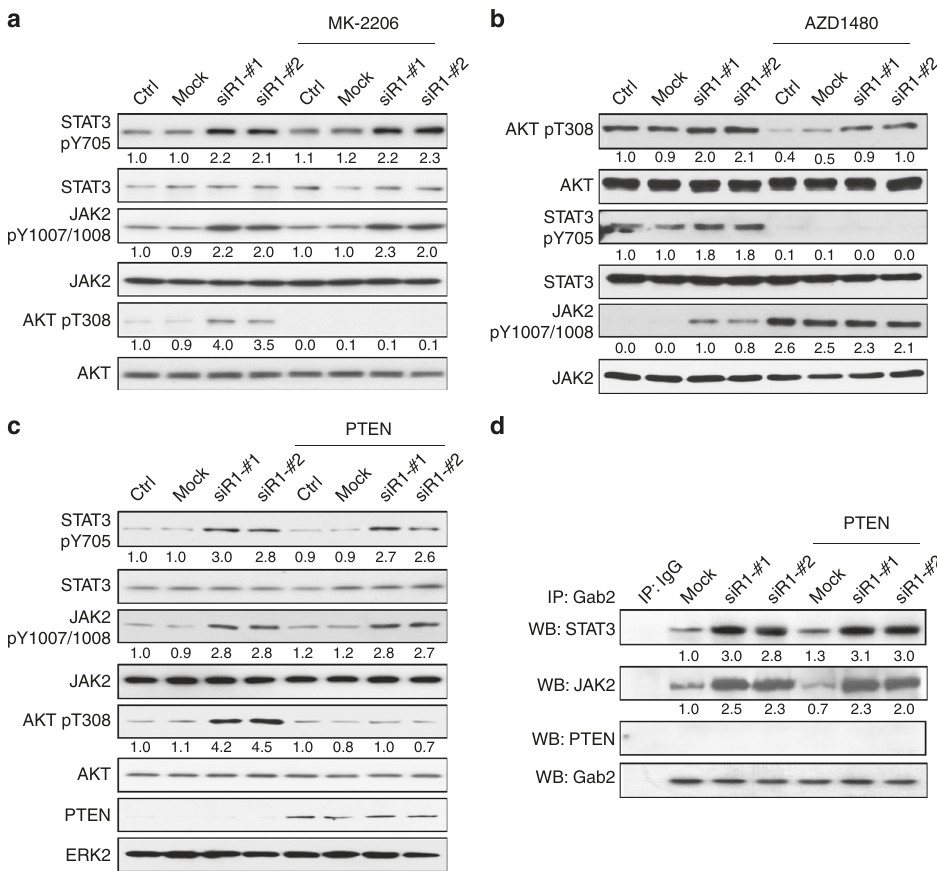
Fig. 6 There is no crosstalk between PIK3R1 loss-induced STAT3 and AKT signaling. a Transfected SKOV3 cells were treated with MK-2206 (2 μ M) or DMSO control for another 24 h. Cell lysates were then subjected to western blotting. b Transfected SKOV3 cells were treated with AZD1480 (5 μ M) or DMSO for 24 h before being harvested for western blotting. c SKOV3 cells co-transfected with PIK3R1 siRNA and PTEN overexpression plasmid for 72 h were harvested for western blotting. d Protein lysates of SKOV3 co-transfected with PIK3R1 siRNA and PTEN overexpression plasmid were immunoprecipitated with Gab2 antibody prior to western blotting. The numbers below the blots represent the mean values from densitometry readings of three independent